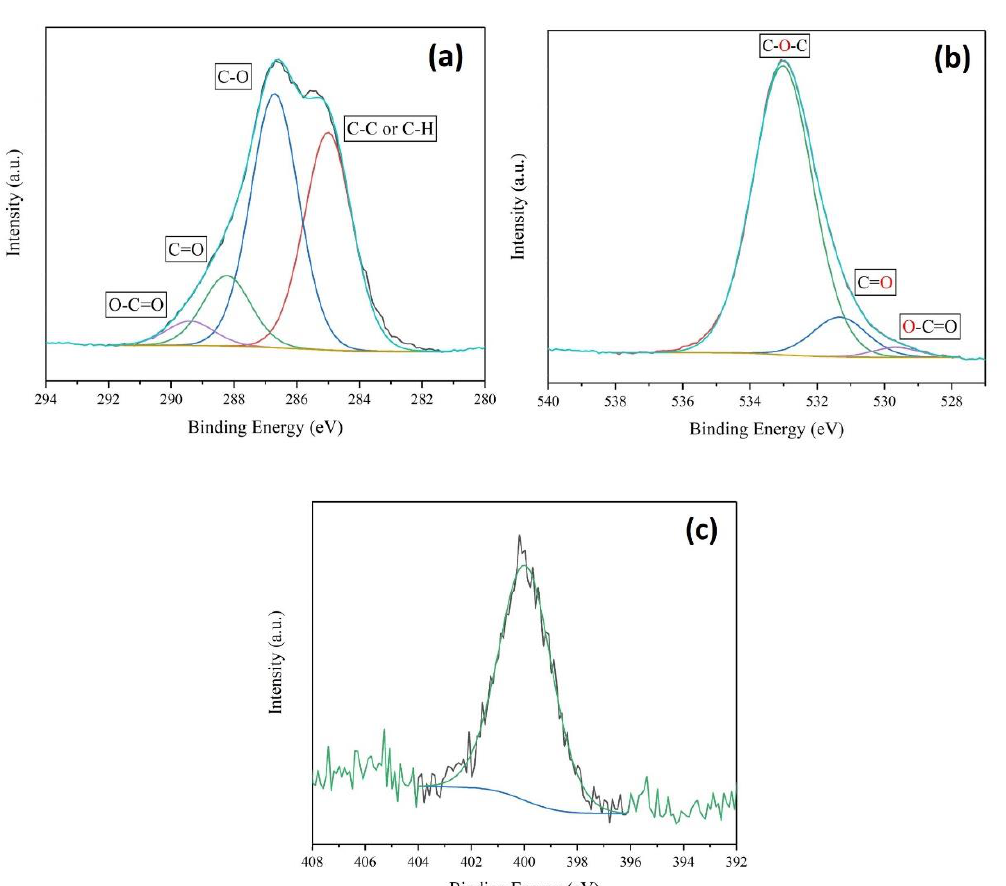
Figure 6. ( a ) C1s, ( b ) O1s, and ( c ) N1s XPS spectra of the CRS sample, also showing the respective deconvolution curves.